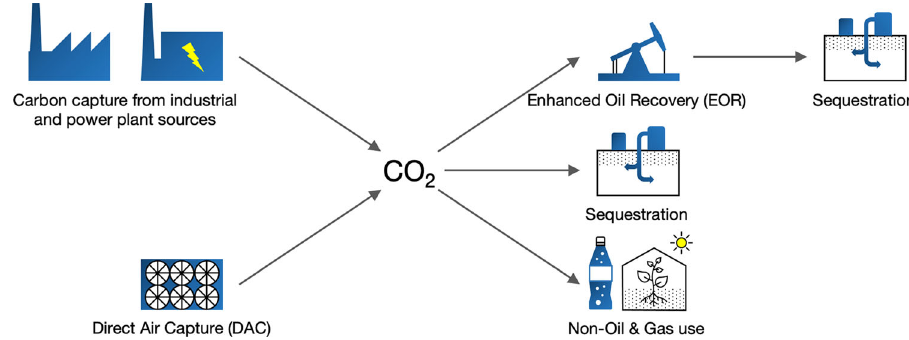
Fig. 1 CO 2 capture pathways. The fi gure depicts the two primary options for technological capture of CO 2 , and the primary use options for captured CO 2 , indicating which of the use options end up with permanent sequestration of the CO 2 . Sequestration refers to the injection of CO 2 into deep subsurface rock formations for long-term storage. Non-oil and gas uses include chemical production processes, the beverage industry, and